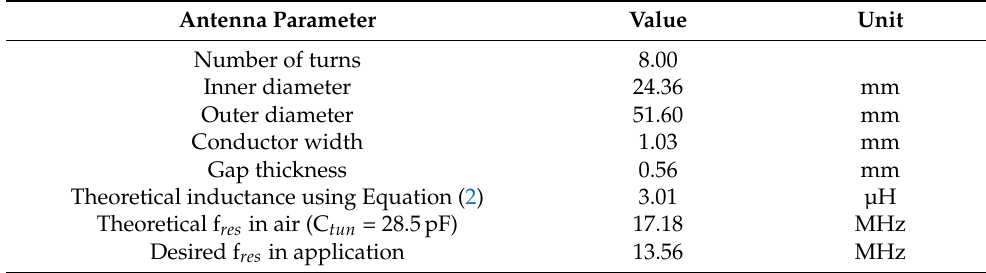
Table 3. Antenna design parameters.